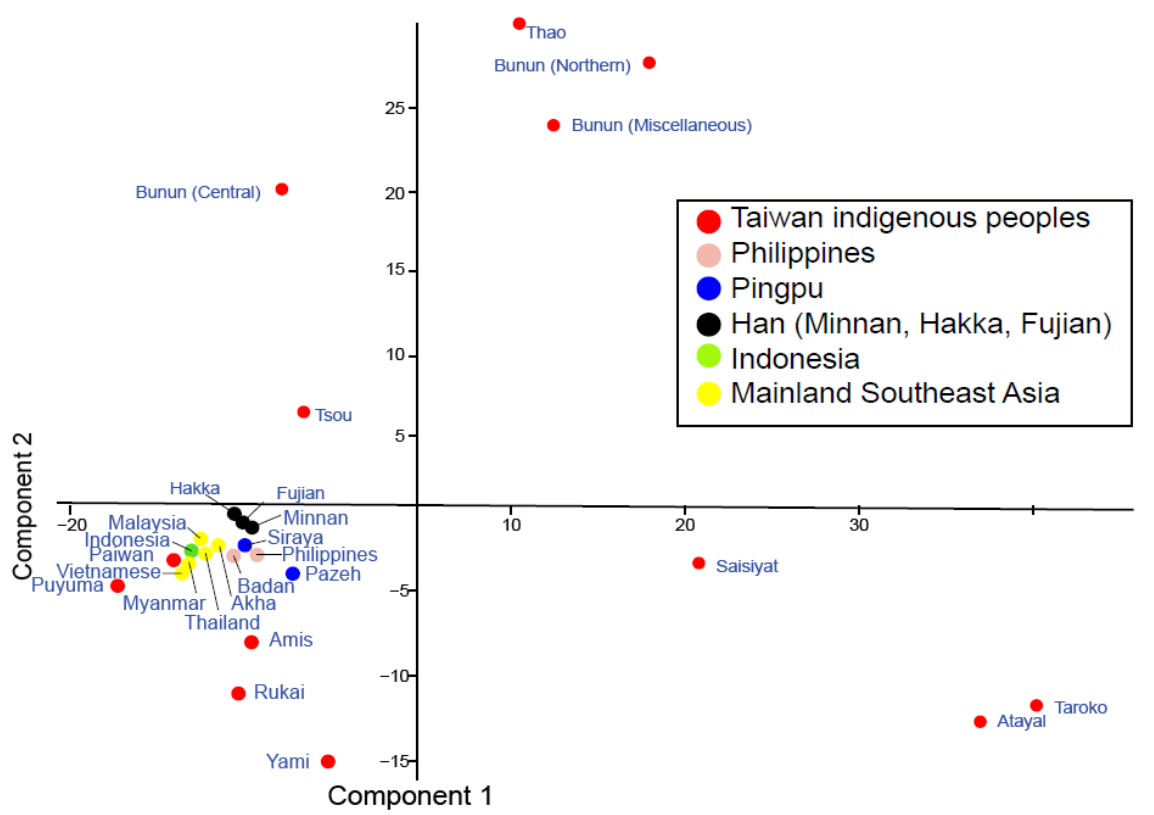
Figure 3. Principal component analysis (PCA) using mtDNA polymorphism of population from MSEA, ISEA, EA, and Taiwan. The PCA plot separates the Northern and Miscellaneous Bunun from the Central Bunun along Component 1 (upper quadrants) and the Northern and Miscellaneous Bunun (upper right quadrant) from the Central Bunun group (upper left quadrant). MSEA, ISEA, and Han form smaller clusters in the lower left pane showing a closer relationship to the Southern AN_Tw (Puyama, Paiwan, Rukai, Amis, and Yami). Pingpu represents the Taiwan Western plain dwellers Pazeh and Siraya people.